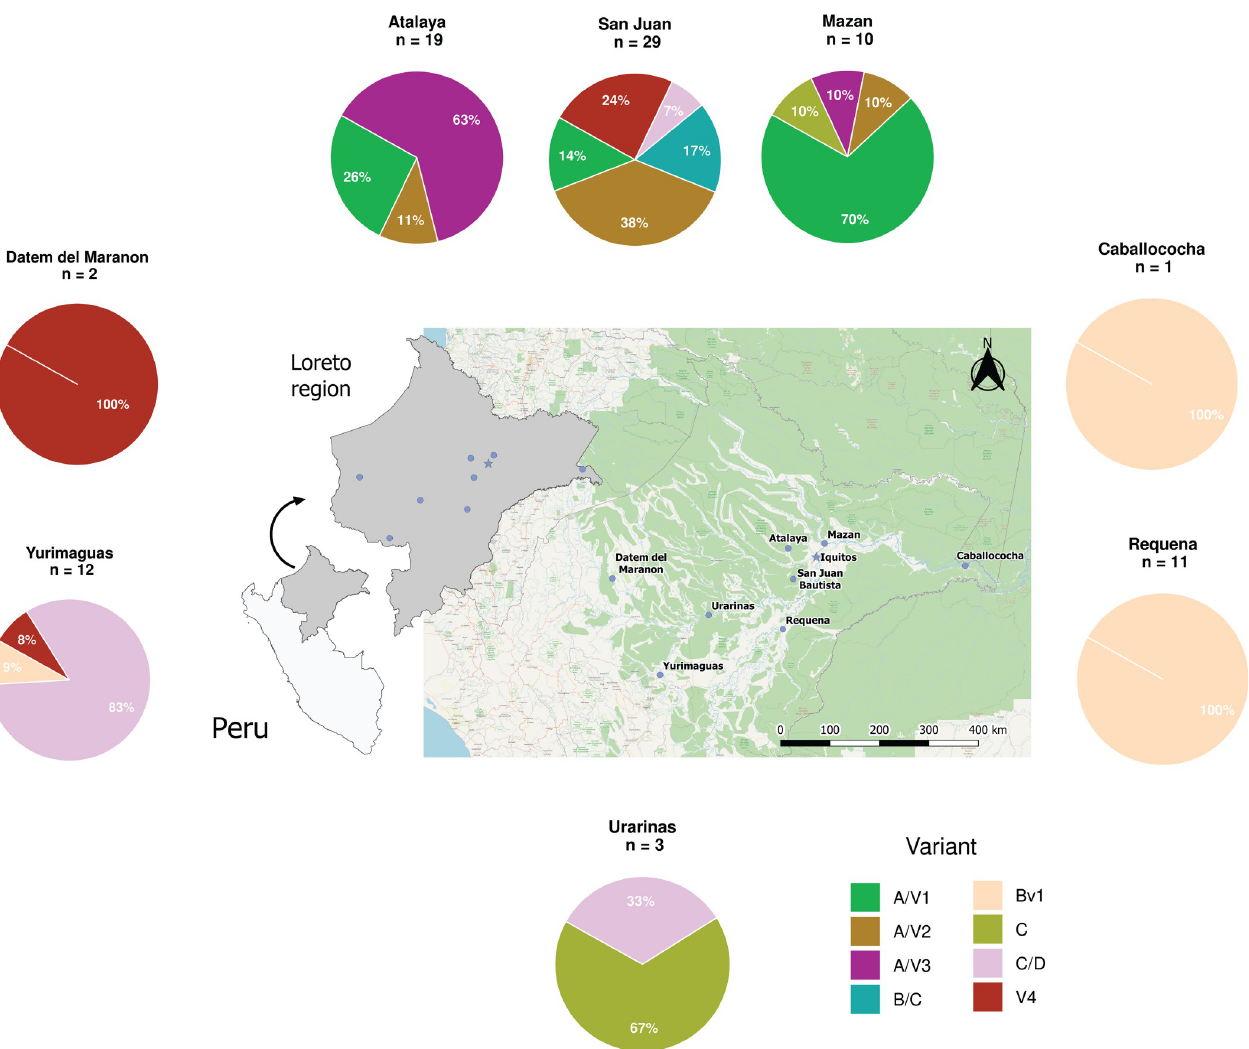
Fig 2. Sample collection sites and lineage distribution in the Peruvian Amazon region. The samples were collected in different areas in the Department of Loreto. Iquitos city, the capital of Loreto is shown by a blue star and the collection sites are shown in blue dots. The proportion of lineages in the study sites are indicated in pie chart and each color represents the lineage